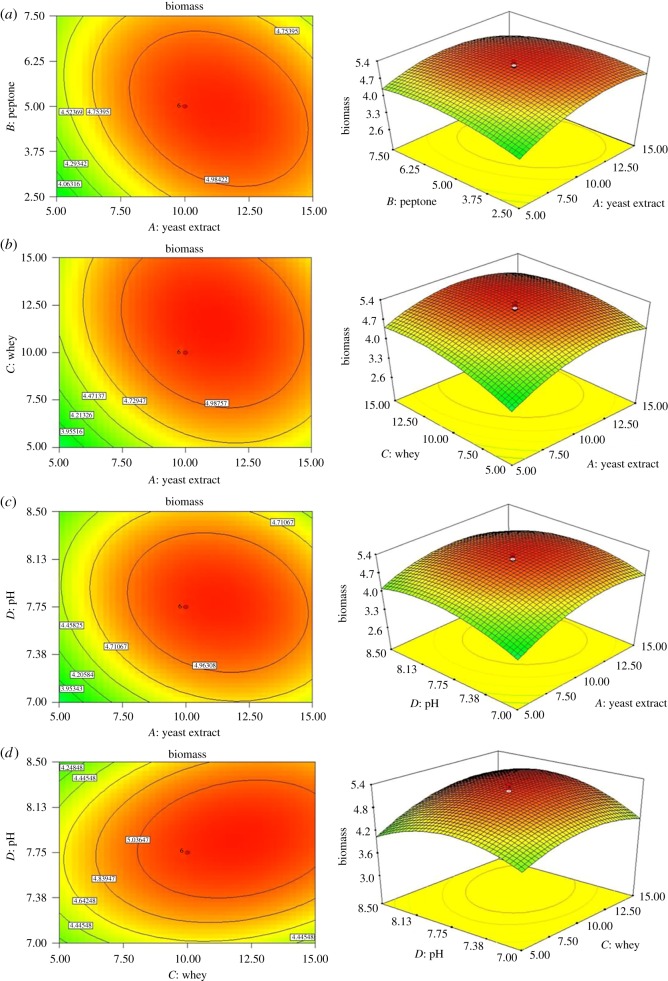
Contour plots and their corresponding 3D diagrams for biomass.